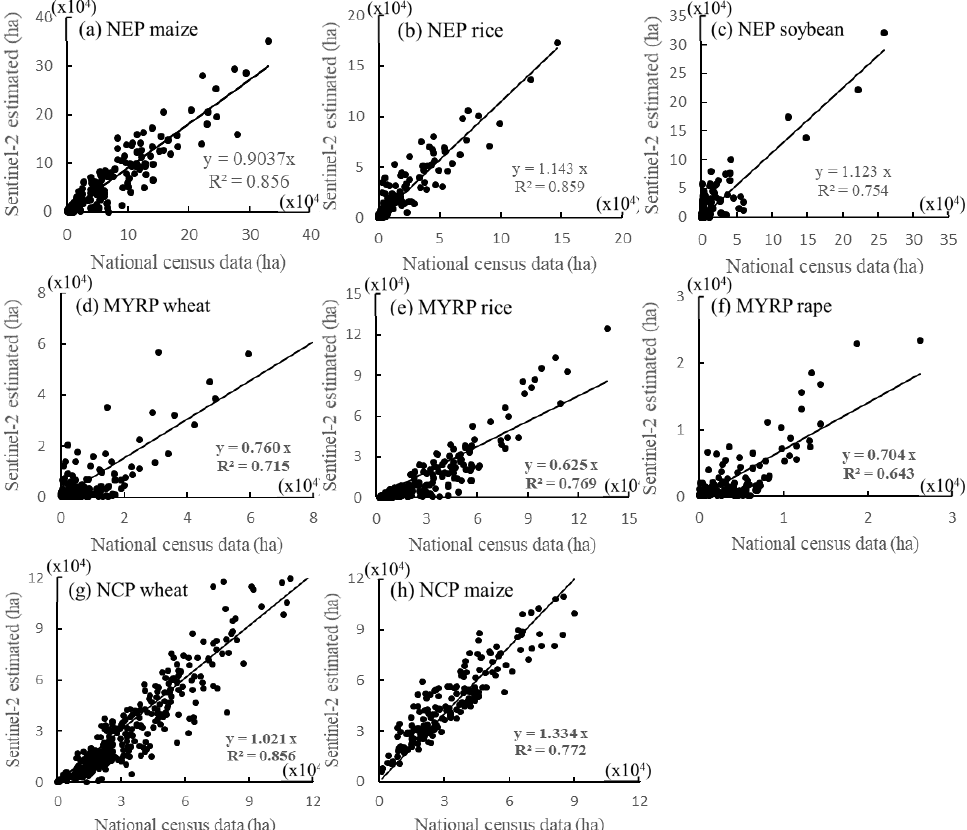
Figure 11. Correlations of areas sown with different crop species between the Sentinel-2-estimated and national census data on the Northeast Plain ( a – c ), middle-lower Yangtze River plain ( d – f ), and North China Plain ( g – h ) .